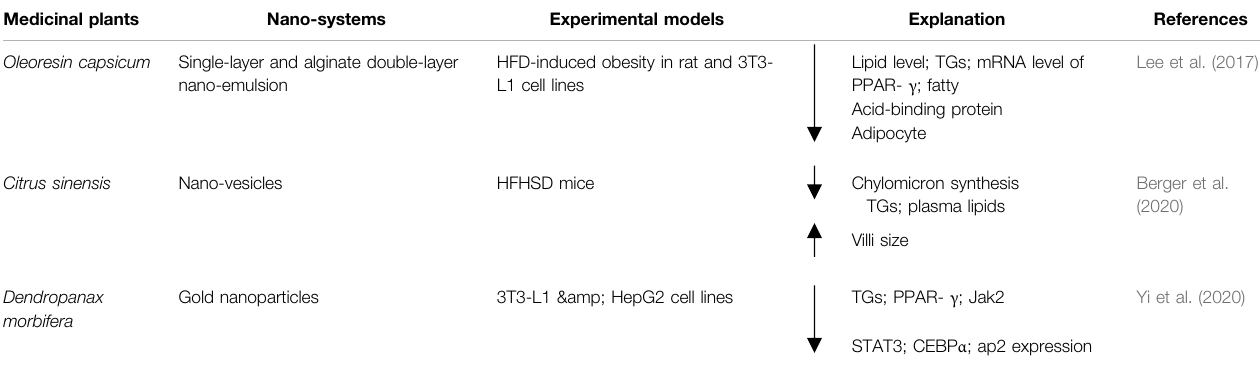
TABLE 3 | Plant extract-derived nanosystems for obesity. Medicinal